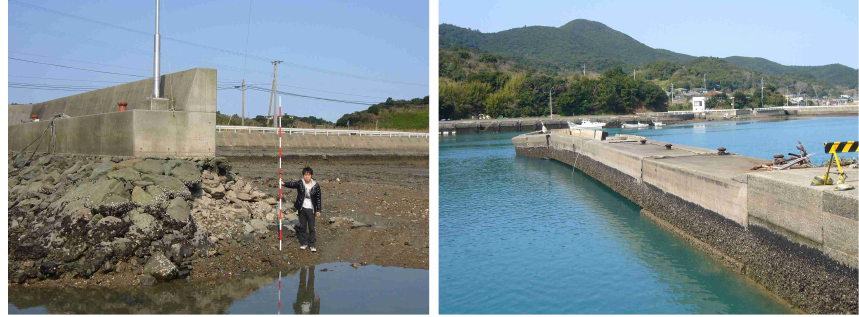
Fig. 4. Photographs of dike damage at Urauchi Bay, Kamikoshiki Island, provided by T. Asano, Kagoshima University.